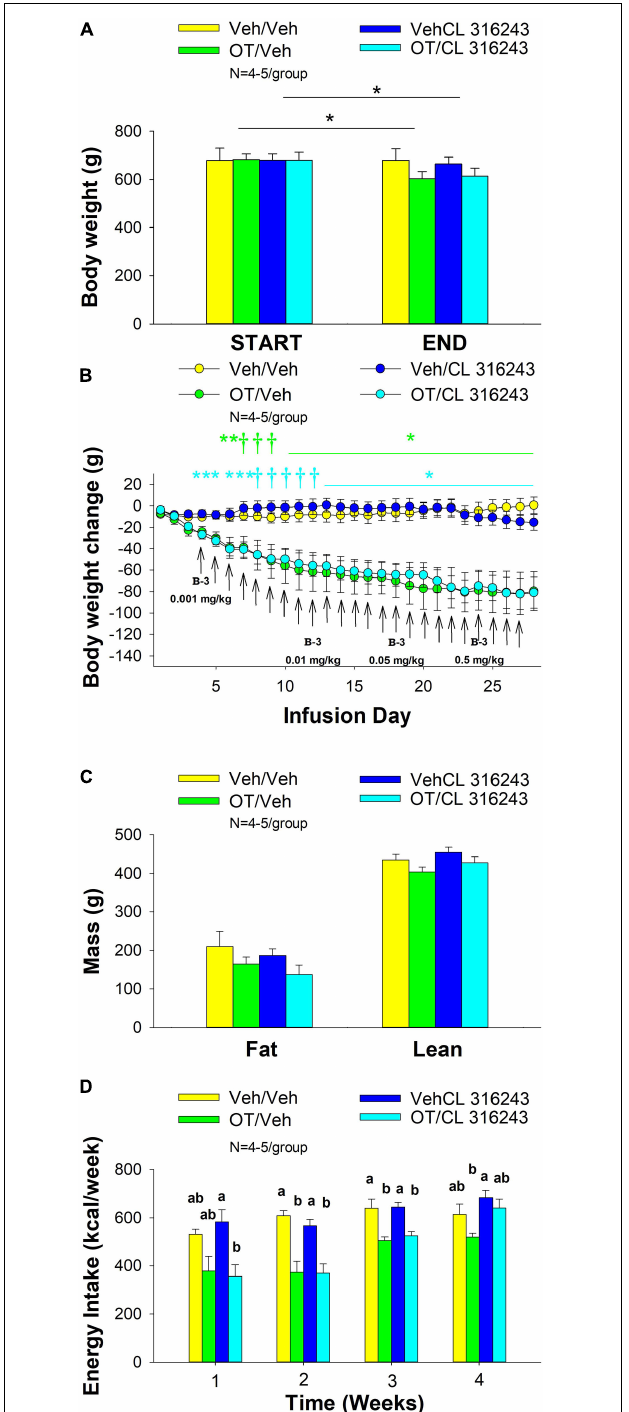
FIGURE 2 | (A–D) Effect of chronic 4V OT infusions (16 nmol/day) and systemic beta-3 receptor agonist (CL 316243) administration (0.001–0.5 mg/kg) on daily body weight, body adiposity and energy intake in male DIO rats. Ad libitum fed rats were maintained on HFD (60% kcal from fat; N = 4–5/group) for approximately 6.5 months prior to receiving continuous infusions of vehicle or OT (16 nmol/day) in combination with